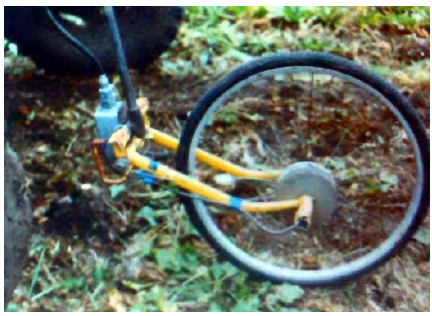
Figure 2. Tractor – harvester aggregate actual speed measuring wheel.